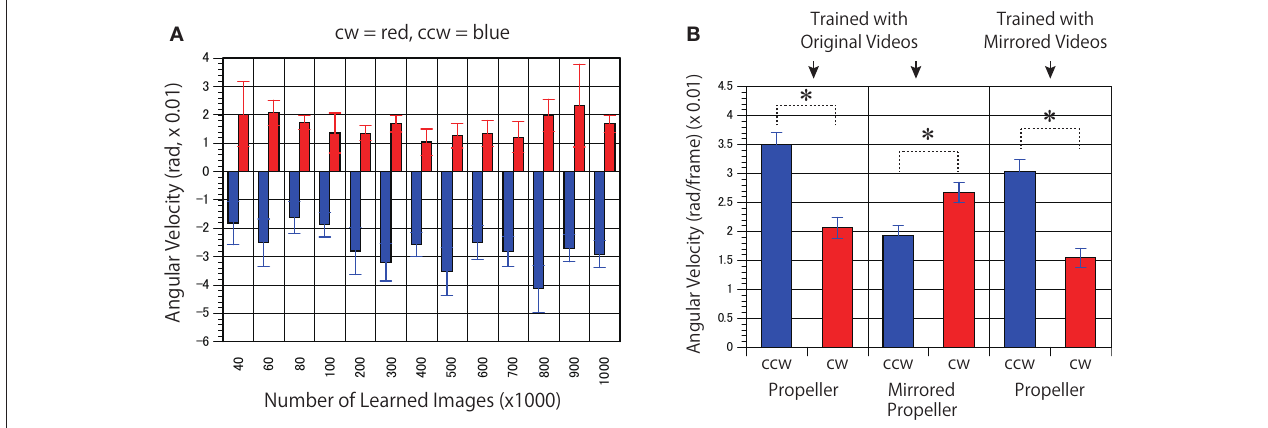
FIGURE 5 | Models trained with mirrored videos also predicted motion in the rotating propellers. (A) The DNNs were trained using mirrored images of the videos of self-motion of viewers. Predicted angular velocities of propellers were calculated as in Figure 4A . (B) Mean angular velocities (P1/P2) derived from 400 to 1000K trained networks were averaged ( n = 7) and set to absolute values. Error bars indicate standard errors. Asterisks indicate a significant difference ( p < 0.01).